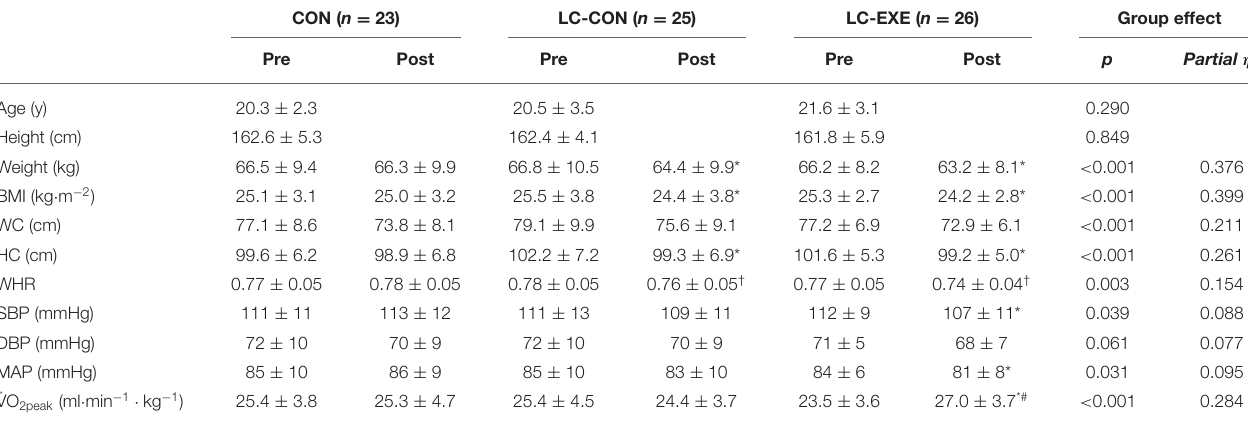
TABLE 1 | Anthropometric and physiological outcomes and blood pressure before and after 4 weeks of